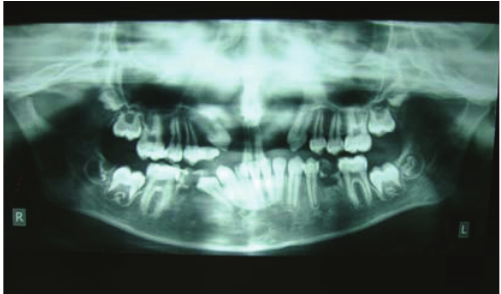
Figure 3: OPG disclosing missing bilateral maxillary lateral incisor tooth